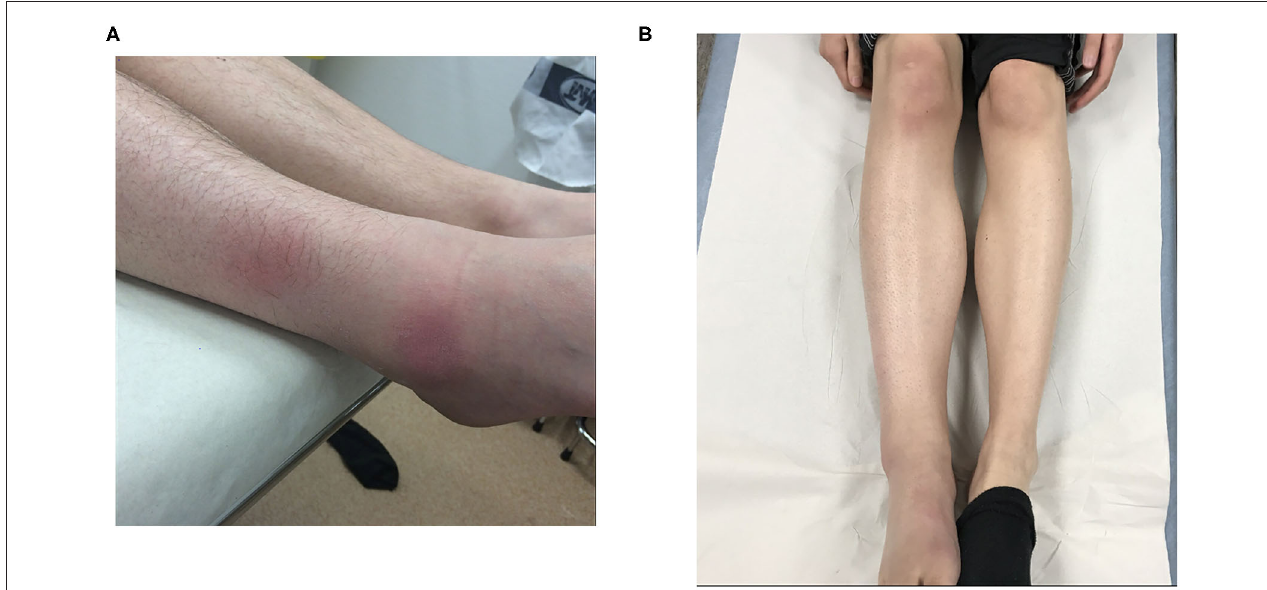
FIGURE 1 | Periarticular swelling of the right leg and ankle. The skin is slightly atrophic adjacent to the two erythematous circular areas seen on the lateral side. The blood vessels appear prominently over the apical part of the foot; a common phenomenon in late cutaneous borreliosis (A) . The right knee, calf, and ankle are swollen, without a distinct erythema. Fifteen to twenty degrees deficit in knee extension was observed. Note the dark discoloration of the medial and apical parts of the foot, typically seen in patients with late cutaneous borreliosis (B)